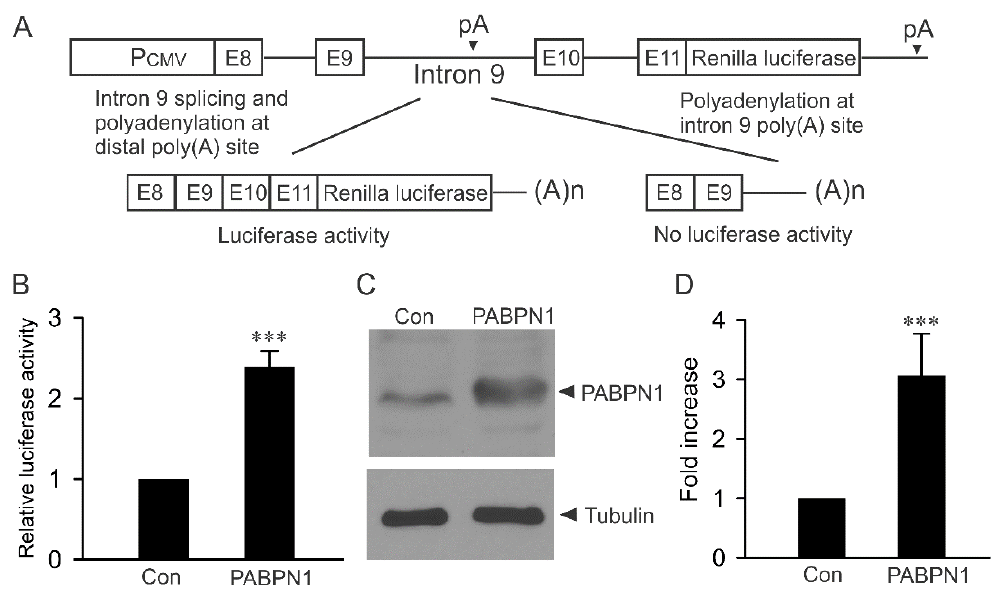
Figure 1. PABPN1 modulates KCNH2 intron 9 alternative processing in luciferase reporter assay. ( A ) Diagram of the KCNH2 minigene luciferase reporter construct. ( B ) Histogram showing luciferase activity was significantly increased following the co-transfection of PABPN1 compared with vector-transfected control. Data were normalized and presented as mean ± standard error (***, p < 0.001, n = 4). ( C ) Immunoblot analysis of PABPN1 expression from HEK293 cells following transient transfection with vector control or PABPN1 using an anti-PABPN1 antibody. ( D ) Histogram showing PABPN1 expression was significantly increased following transient transfection compared with vector-transfected control (***, p < 0.001, n = 4, error bars, mean ± S.E.).